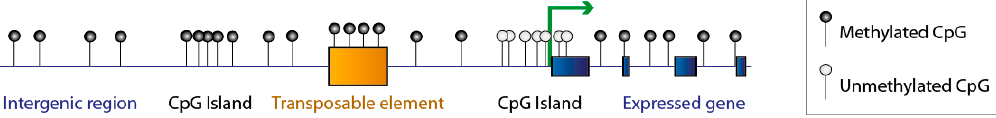
Figure 1. Genome-wide distribution of DNA methylation in mammalian species. DNA methylation occurs symmetrically on CpG sites: to simplify, only one DNA strand is shown on this figure. The mammalian genome has a low frequency of CpGs, but the majority of these are methylated (black lollipops) in intergenic regions, repeated elements and transposable elements, and in gene bodies. Conversely, CpG islands are rich in CpGs and are usually protected from DNA methylation (white lollipops). Unmethylated CpG islands frequently correspond to active promoters (green arrow).